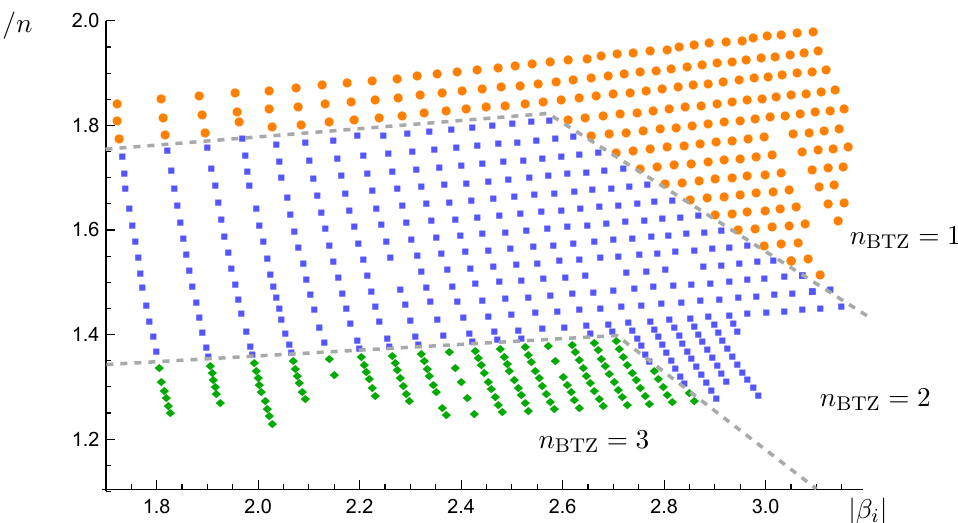
Figure 8 . Numerical computation of n BTZ for di(cid:11)erent values of the moduli. Suggested phase boundaries are drawn by hand in dashed grey, each consisting of two linear segments. The kink corresponds to a transition in dominance between two distinct AdS